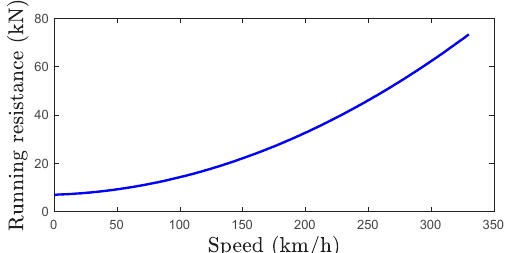
Figure 3. Running resistance for the Talgo-Bombardier class 102 train. It is modelled by using Equation (6).